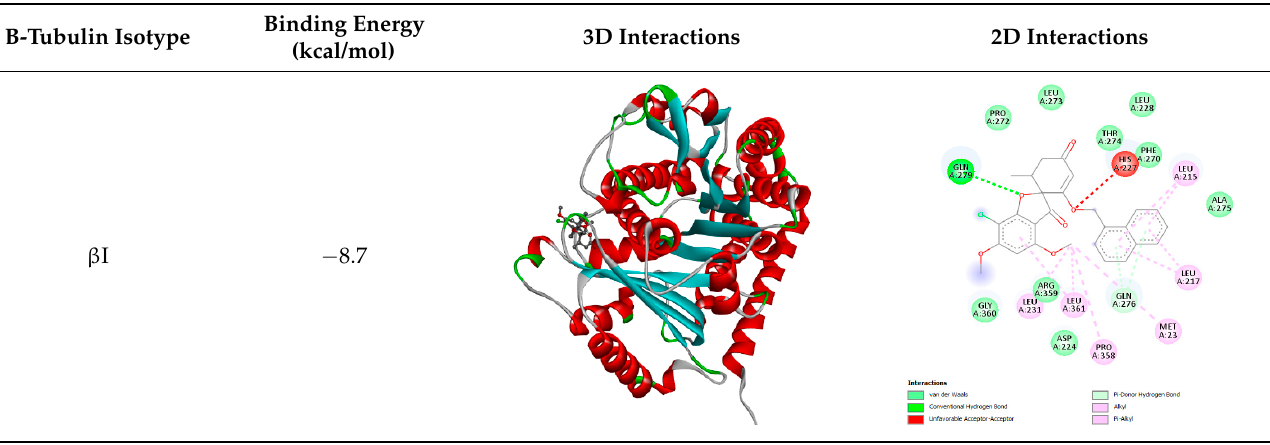
Table 4. The 3D- and 2D-binding conformations and active residues involved in interactions between compound G1 and nine distinct β -tubulin isotypes.